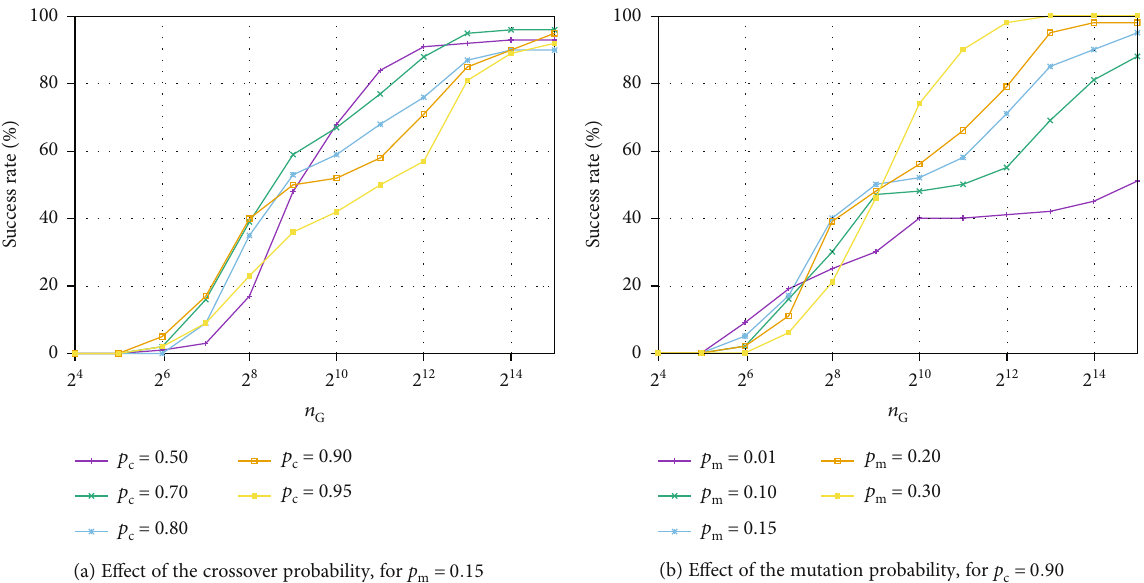
Figure 10: GA success rate along the evolution process for the 12-target mission, with di ff erent crossover p population size is n = 64 P